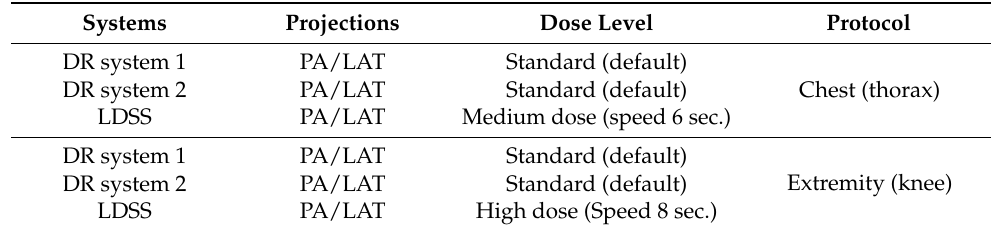
Table 1. The list of study protocols and radiation dose level settings used in both patient dose and image quality comparisons of the LDSS and the DR